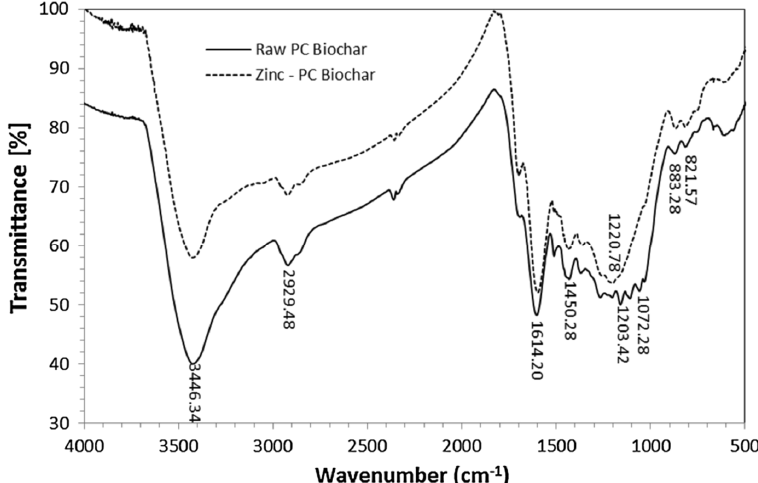
Figure 10. The FT-IR spectra of raw and Zn-loaded pine cone biochar [116]. Reprinted with permis- sion from N. Van Vinh et al. (2015). Copyright 2015, Springer. sion from N. Van Vinh et al. (2015). Copyright 2015,